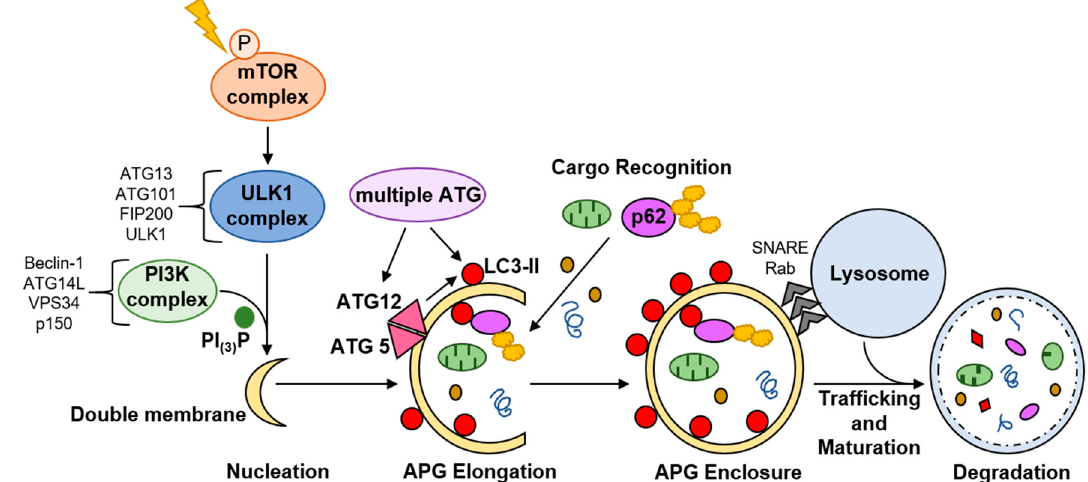
Figure 3. Simplified schematic of macroautophagy. There are more than 30 proteins directly involved in this highly coordinated process. A stimulus induces phosphorylation of mTOR, inactivating the mTOR complex. This releases the UNC-51 like kinase (ULK1) pre-initiation complex from inhibition, which then recruits a class III phosphatidylinositol 3-kinase (PI3K) complex. This enriches for phosphatidylinositol-3-phosphate (PI (3) P) at intracellular membrane sites, most commonly the ER and mitochondria, resulting in nascent double membrane formation. This new autophagosome (APG) is docked by a functional autophagy-related (ATG) 5–ATG12 complex that is activated by other ATG proteins. This complex, in concert with other ATG proteins, processes LC3: LC3 is cleaved and lipidated with phosphatidylethanolamine to form LC3-II that associates with the inner and outer membrane of the forming APG to facilitate elongation and enclosure as well as cargo recognition. Sequestrome-1 (SQSTM1/p62), one autophagy receptor, binds to LC3-II to include specific cargo inside the forming APG, imparting selectivity to degradation. The APG membrane closes around cargo, is trafficked to a lysosome, and its outer membrane fuses with a lysosome through the action of Rab family GTPases, and soluble N-ethylmaleimide-sensitive factor-attachment protein receptor (SNARE) superfamily proteins in a process called maturation. This results in creation of the autolysosome and degradation of APG cargo. While the LC3-II on the inner APG membrane is degraded within the autolysosome, the LC3-II on the outer membrane can be recycled back to LC3-I to participate again in APG